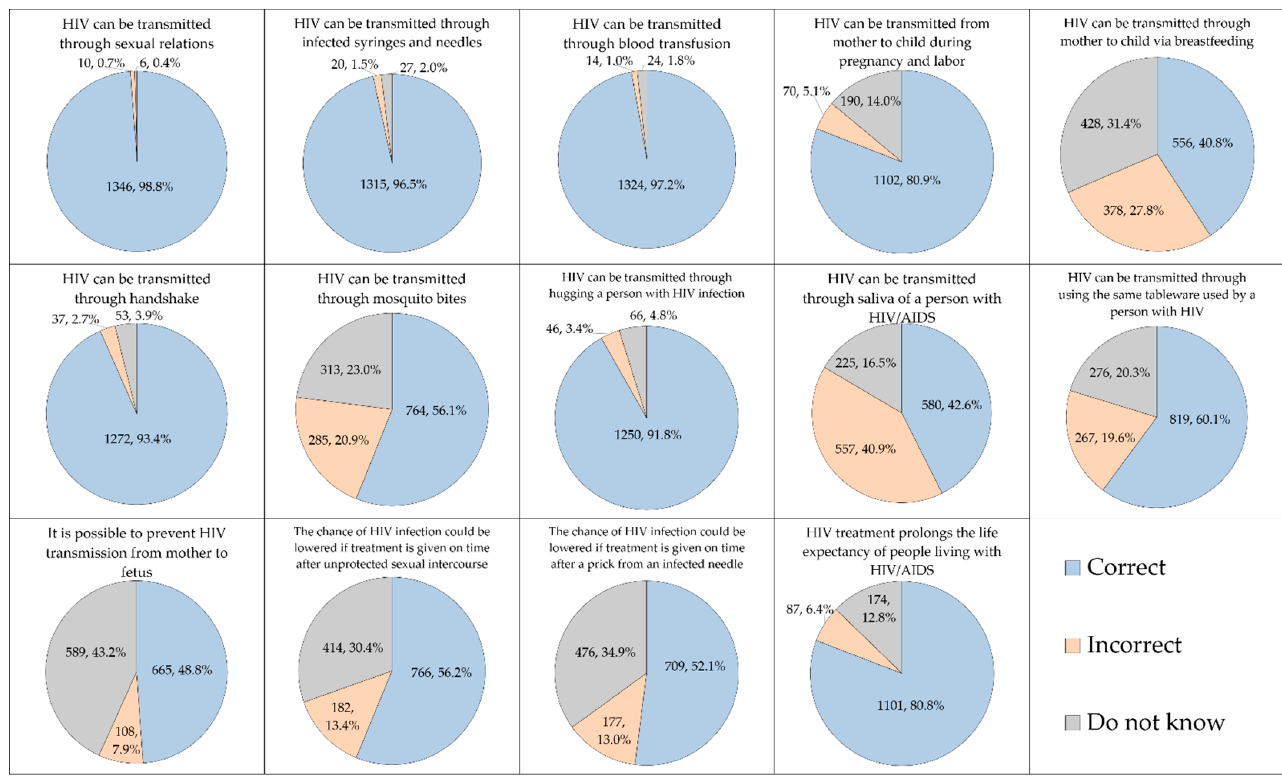
Figure 1. The participants’ knowledge on HIV transmission, management and prevention. HIV: Human immunodeficiency virus; AIDS: Acquired immunodeficiency syndrome.